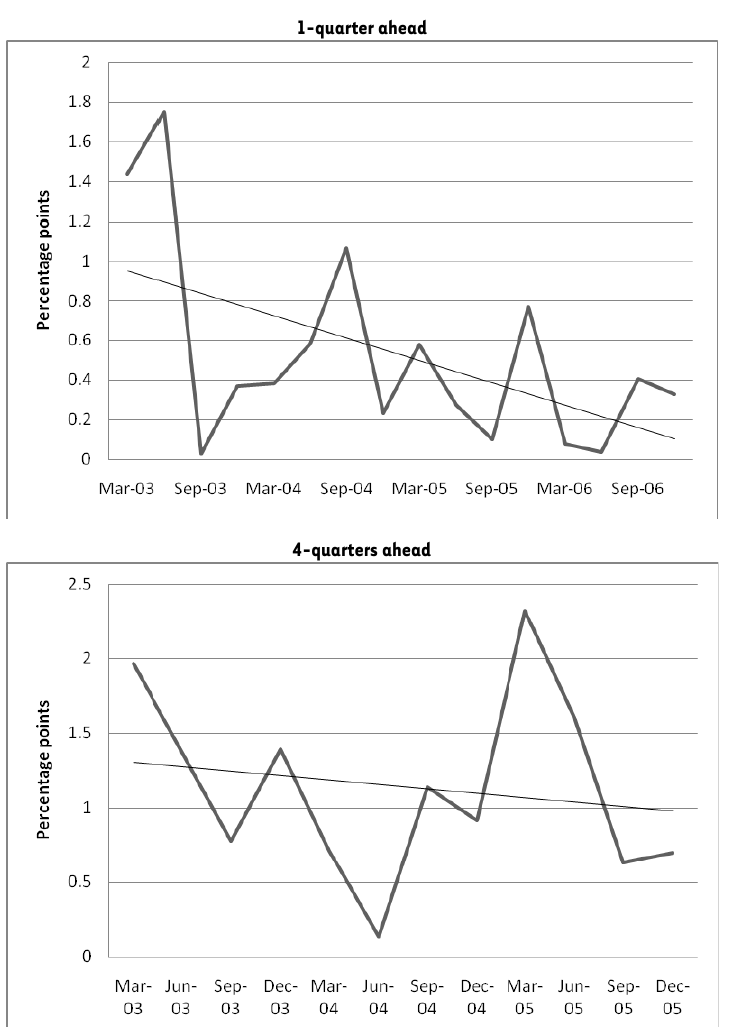
FIGURE 8b: CPIX Inflation: Forecast Errors, 2003-2006